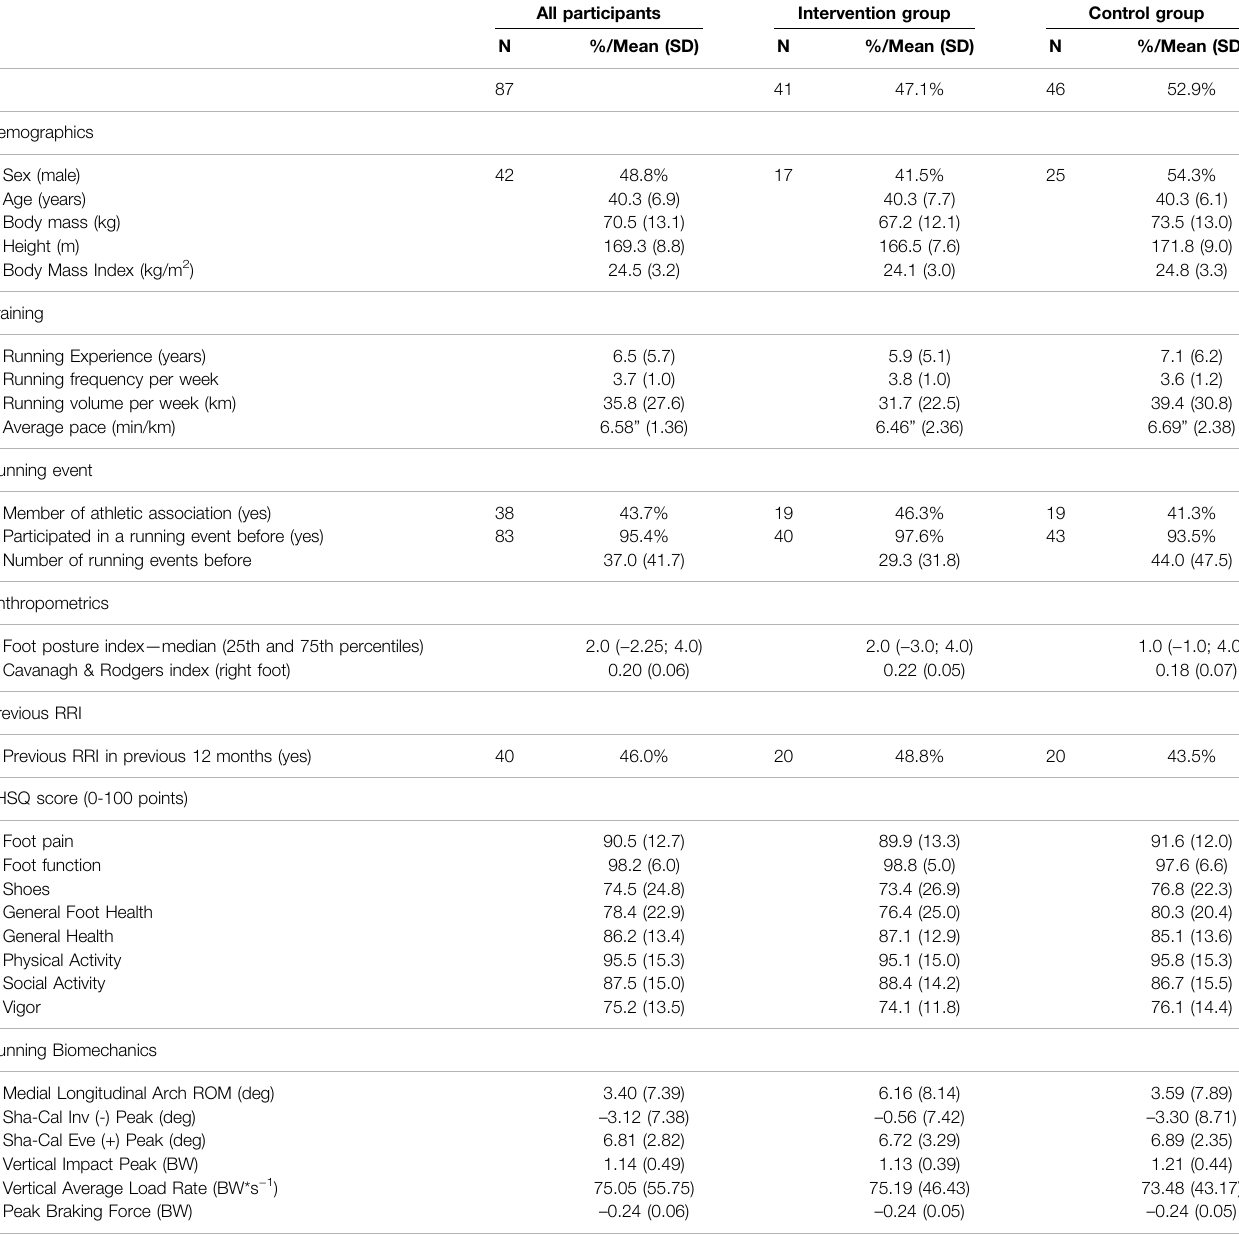
TABLE 2 | Baseline characteristics of participants from the intervention and control groups.